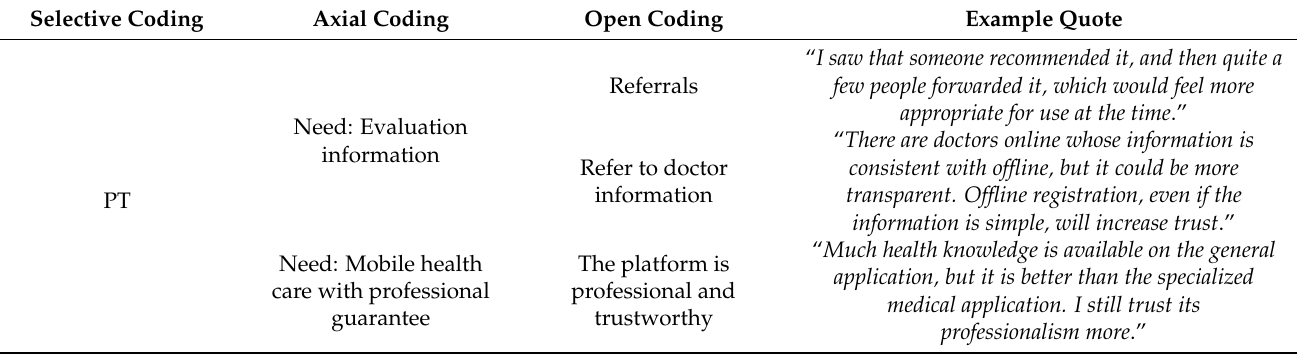
Table 2. Examples of qualitative analysis: PT. Selective